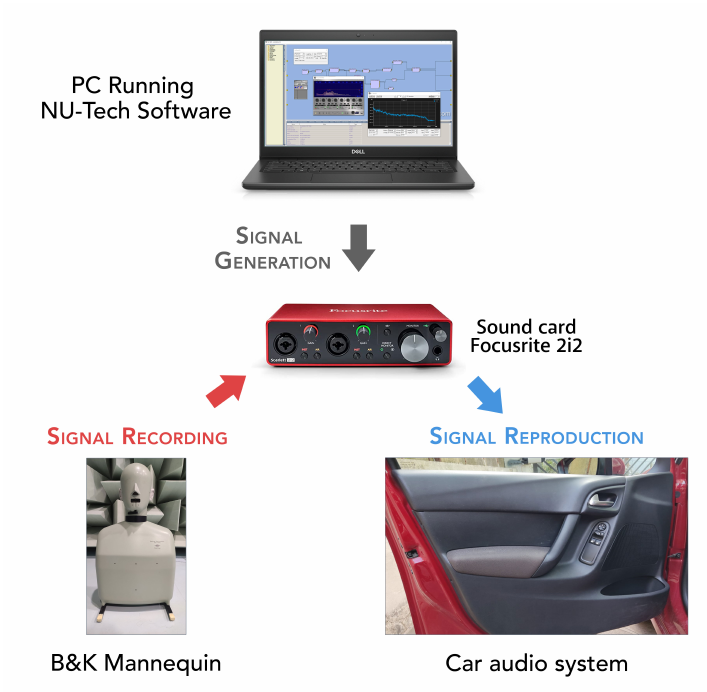
Figure 1. Overall scheme of the acquisition procedure for the real scenario.